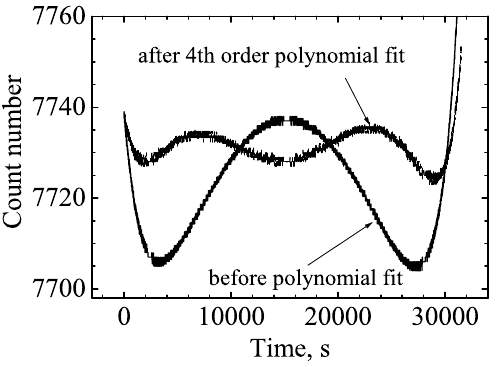
Fig. 9. The light curve of a comparison after extinction correction by the standard QED procedure (Case I) without a poly- nomial fit and with a 4th order polynomial